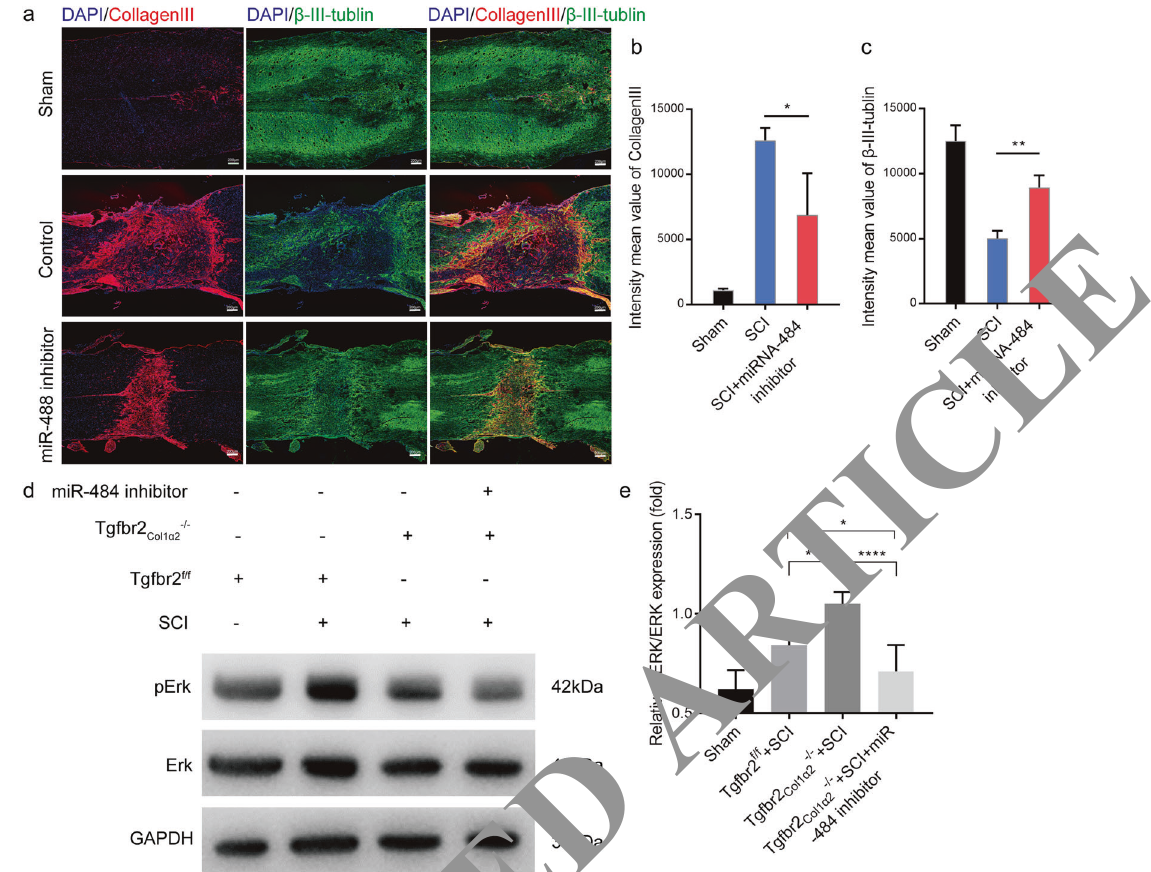
Fig. 7 Improved neurological functional recovery and decreased fi brotic scar formation after inhibiting the expression of miR-488. a Representative images of immuno fl uorescence analysis of collagen III (red), β -III-tublin (green) and DAPI (blue) in miR-488 inhibitor-treated mice and control group mice after SCI and mice without surgery (Sham) at 2 weeks. Scale bars = 200 μ m. b , c Quantitative analysis of intensity mean value of collagen III and β -III-tublin in each group (* p < 0.05, ** p < 0.01, n = 4). d The regulatory mechanism of miR-488 was through MAPK signaling pathway. Representative western blots showing the expression of pErk and Erk in the lesion area of spinal cord from Tgfbr2 f/f mice without SCI, Tgfbr2 f/f mice with SCI, Tgfbr2 Col1 α 2 − / − mice with SCI and Tgfbr2 Col1 α 2 − / − mice with miR484 inhibitor treatment after SCI in vivo. e Quantitative analysis of the relative pErk/ Erk expression in different groups (* p < 0.05, *** p < 0.001, **** p < 0.0001, n = 3).